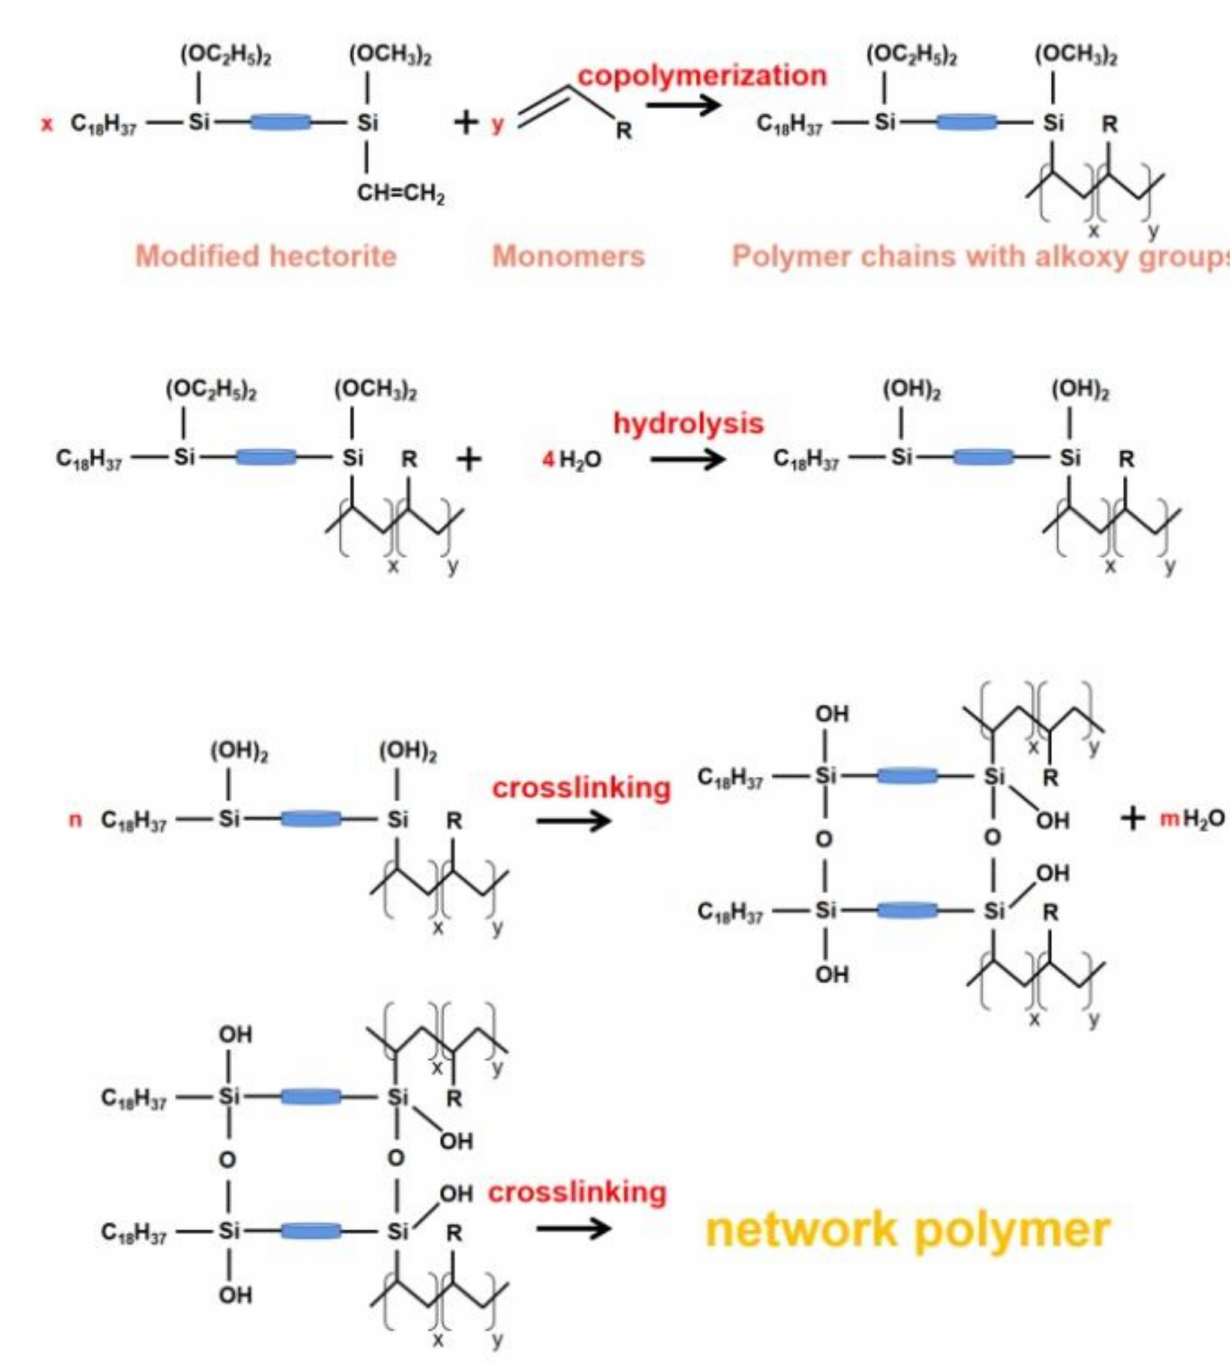
Scheme 3. Schematic illustration of the Pickering polyacrylate latex reaction